Question: Provide a one-line summary of what is displayed.
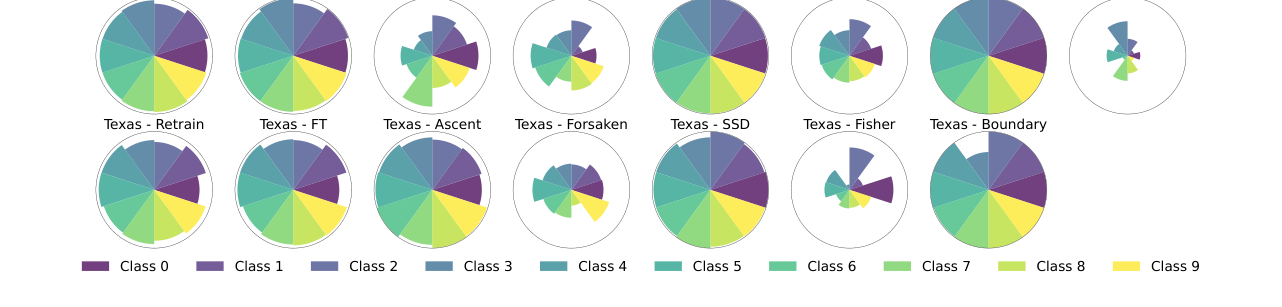
Answer: Partial class unlearning results (AUC) of 10 classes